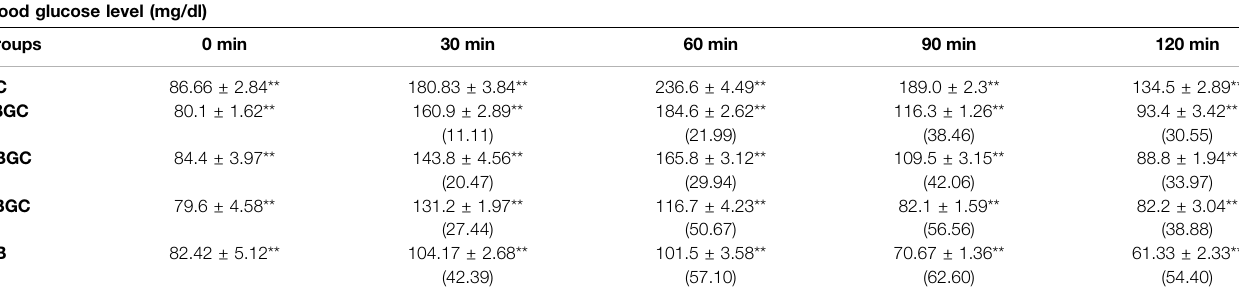
TABLE 2 | Effect of JBGC, KBGC and SBGC on blood sugar level in glucose overloaded Swiss albino mice at various time intervals. Blood glucose level (mg/dl)